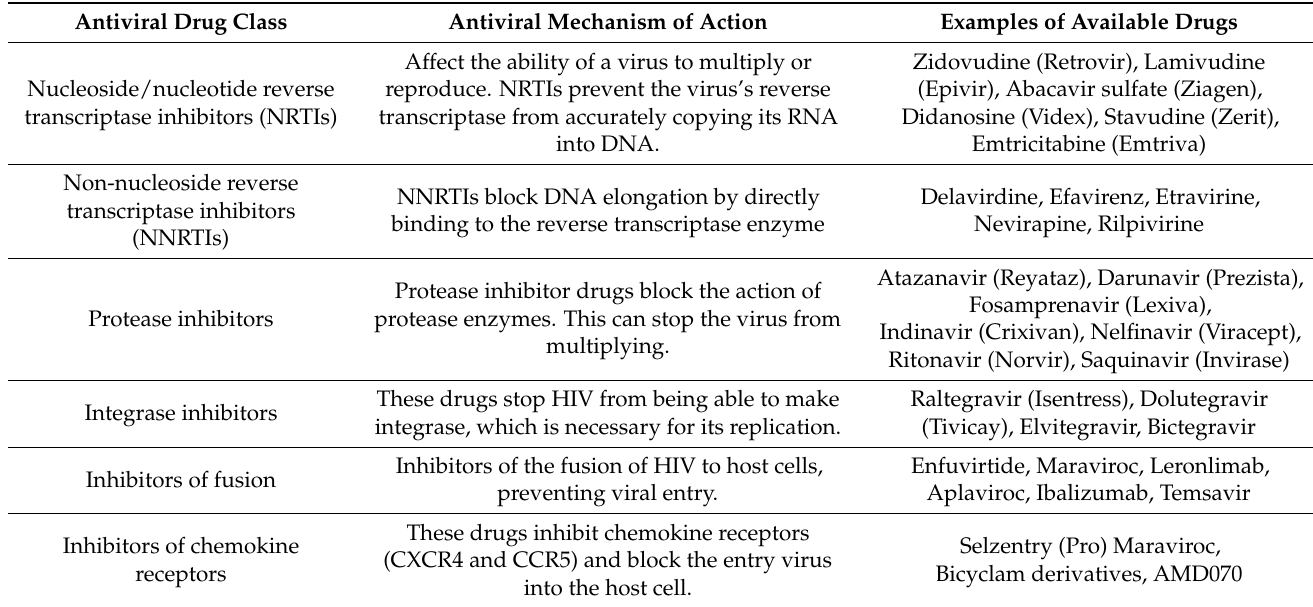
Table 1. Antiretroviral drugs that act on various targets of the